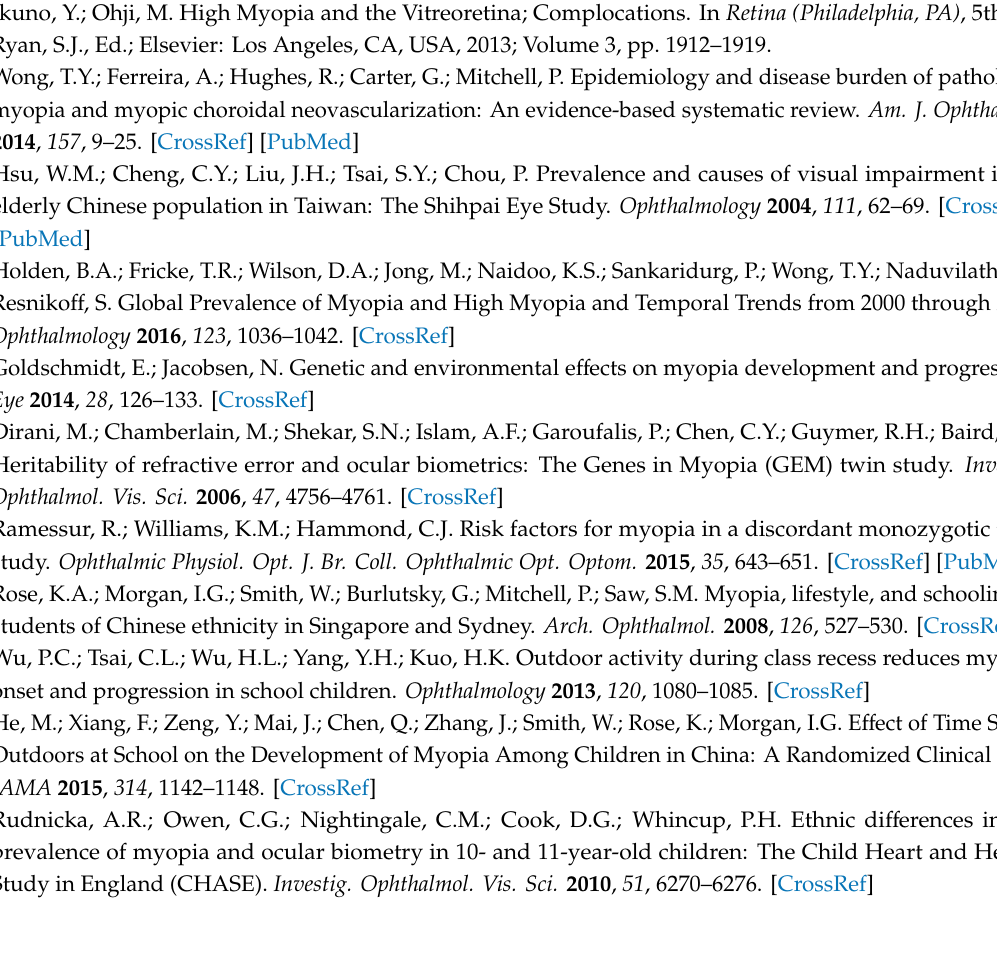
Table S1: The association between alcohol, tobacco and high myopia. Table S2: Logistic regression analysis to identify factors associated with high